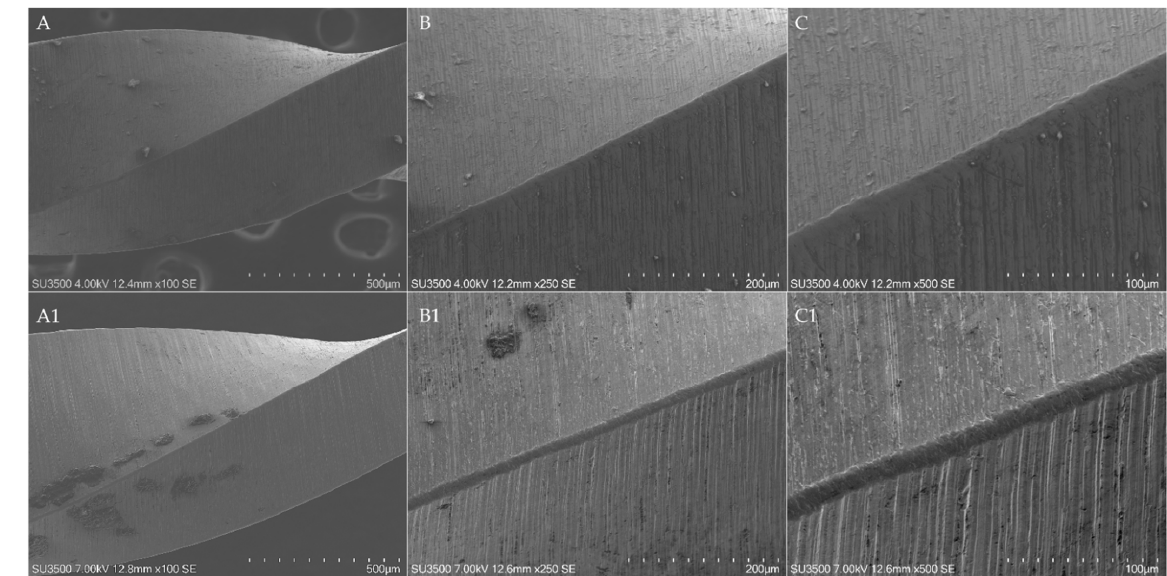
Figure 6. SEM images representing the flattening of cutting edges of EOF instrument after 4 simulated clinical uses at three different magnifications (from left to right respectively of × 100, × 250 and × 500). ( A – C ) cutting edge of EOF new instrument. ( A1 – C1 ) the same cutting edge of the EOF instrument acquired after 4 simulated clinical uses.